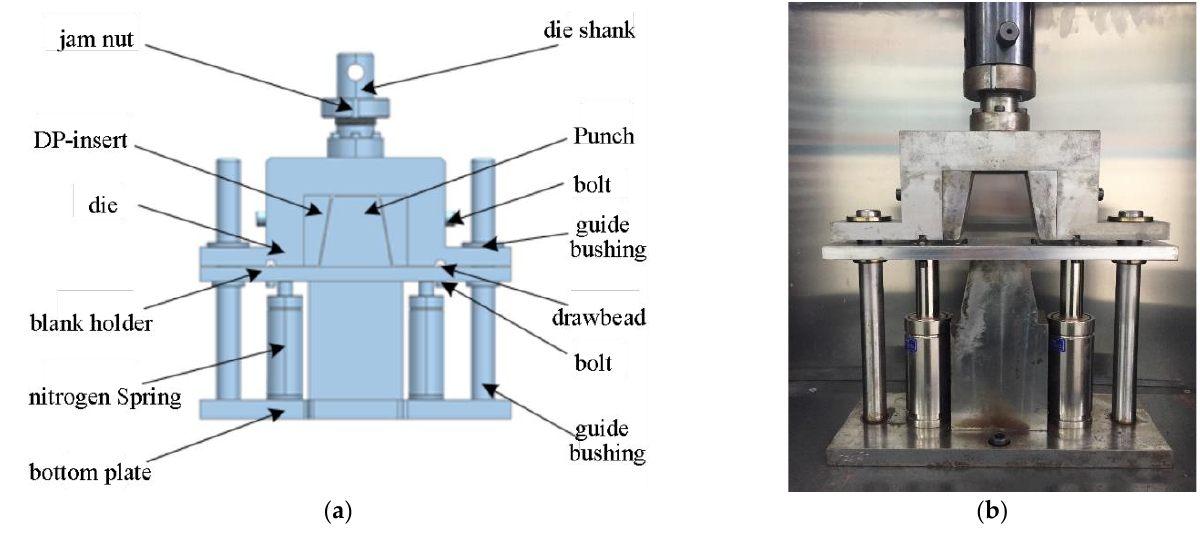
Figure 2. Experimental mold design and real object.